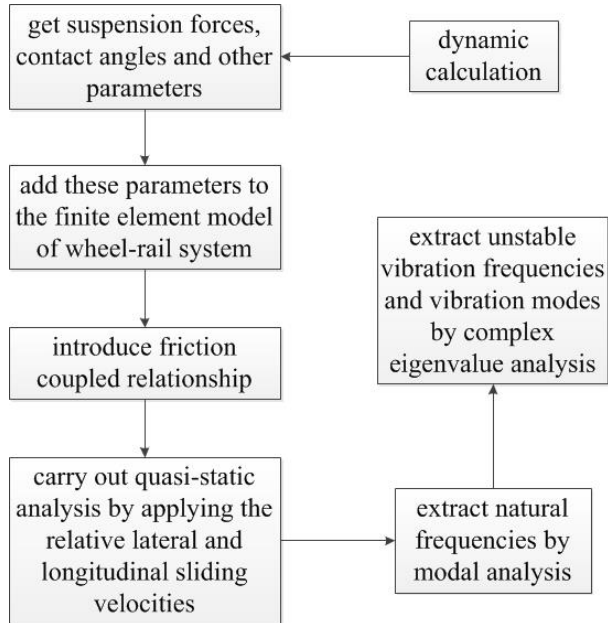
Figure 3. Calculation process of effective damping ratios.